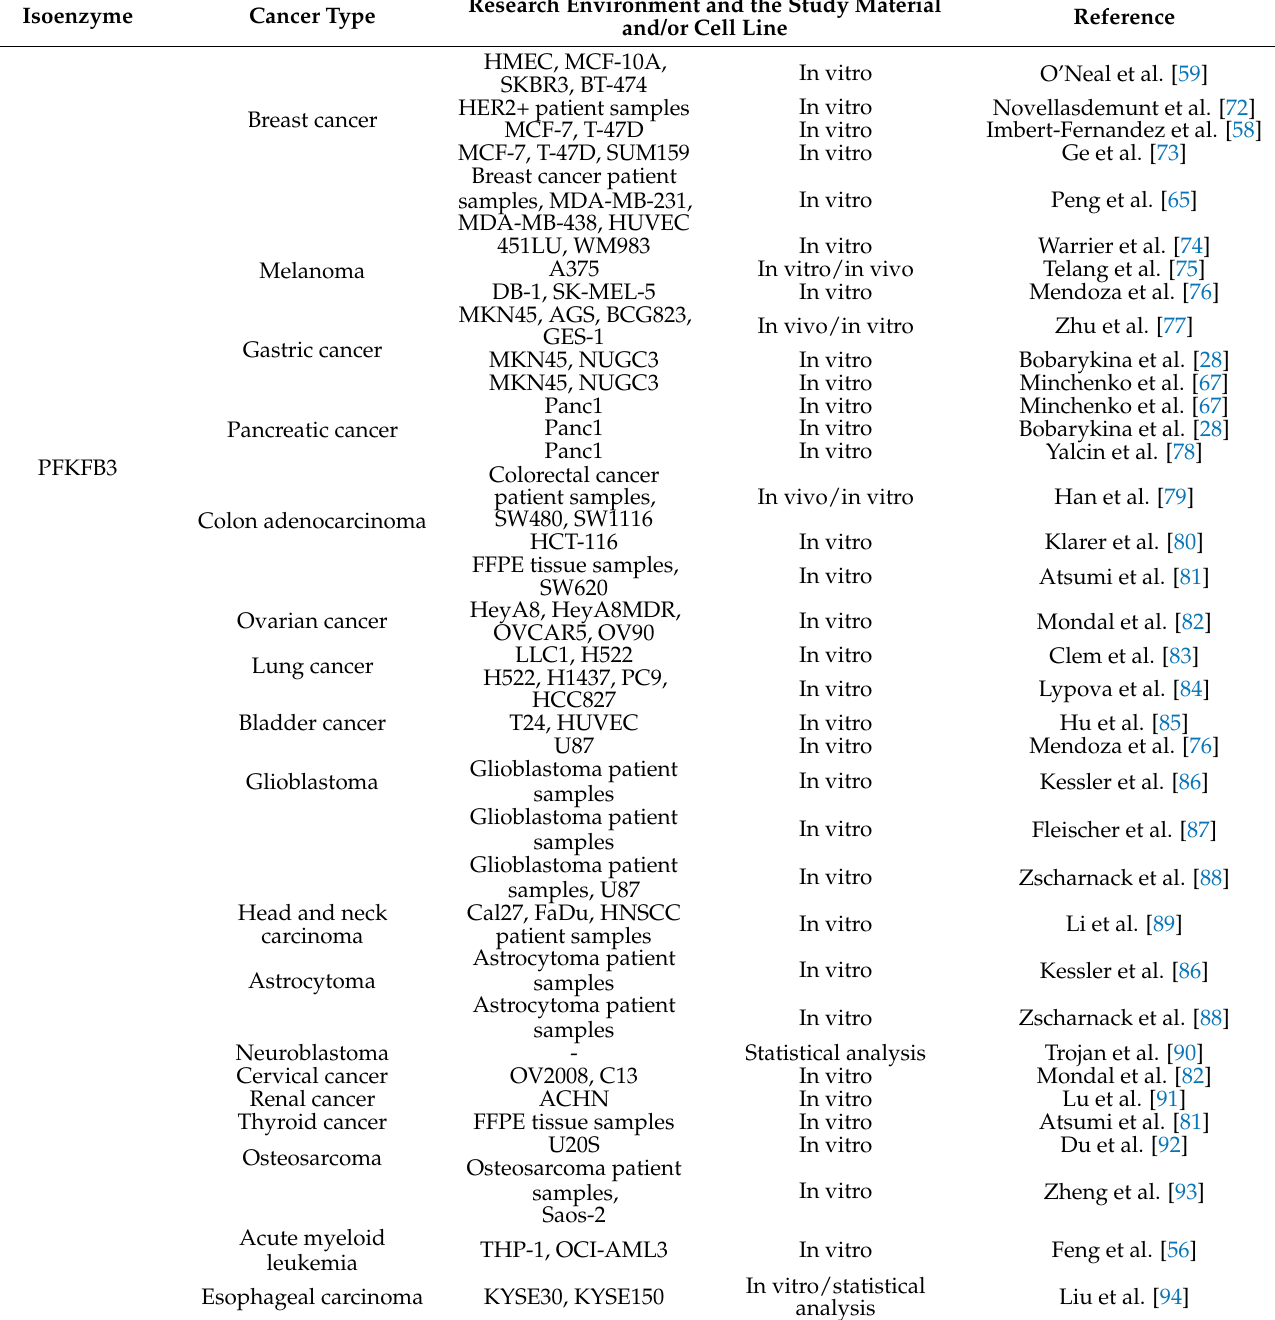
Table 1. Expression of PFKFB3 and PFKFB4 in various cancer